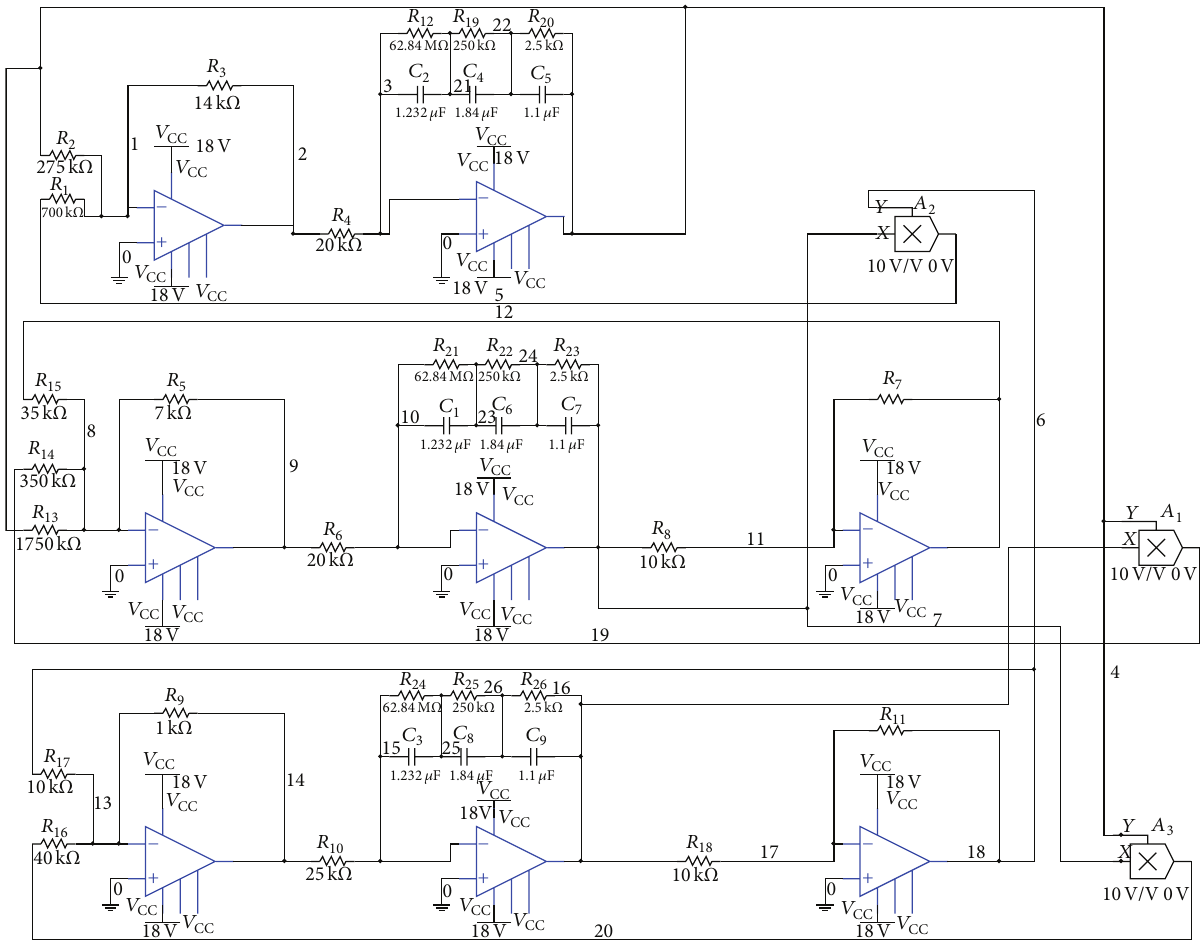
Figure 4: Circuit diagram to realize the new fractional-order chaotic system